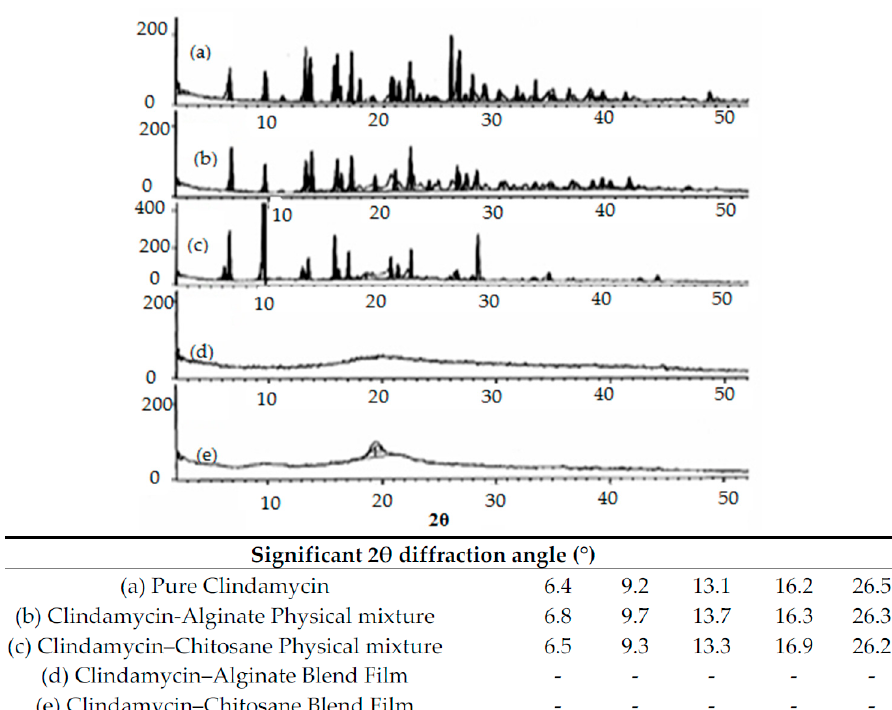
Figure 8. Significant data and X-ray curves of (a) pure clindamycin; (b) clindamycin-alginate physical mixture; (c) clindamycin-alginate blend films; (d) clindamycin-chitosan physical mixture; (e) clindamycin-chitosan blend films.